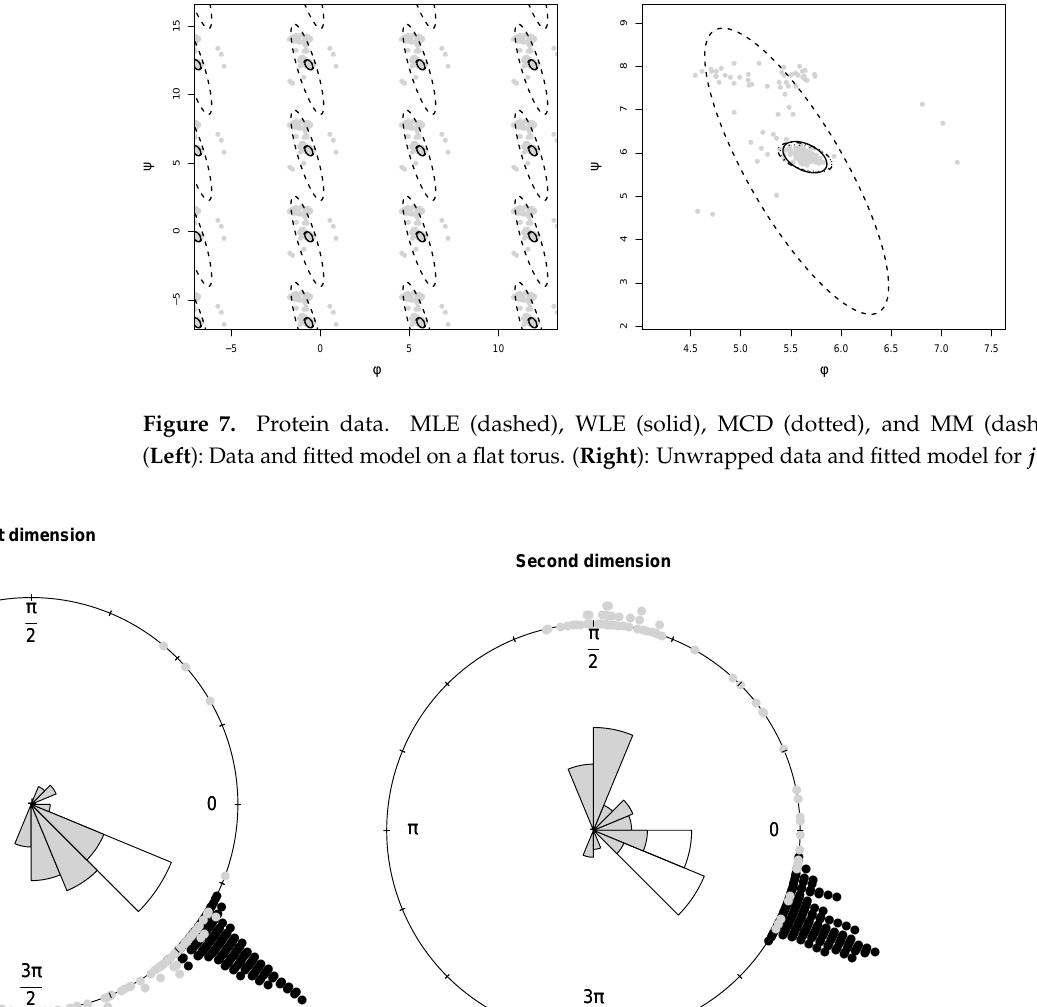
Figure 8. Protein data. Rose diagrams. Genuine points (black) and outliers (gray) stemming from the reweighted